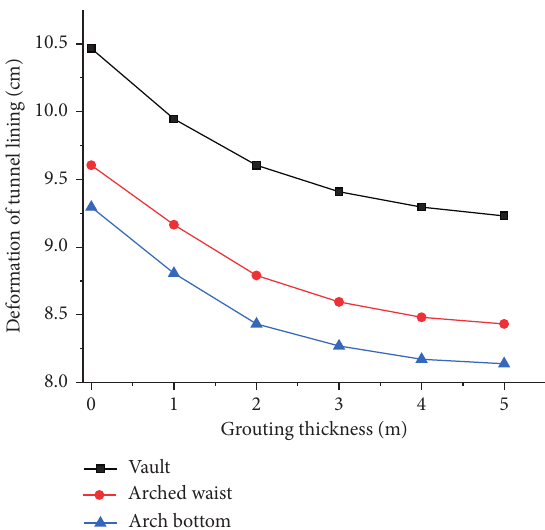
Figure 12: Lining displacement under different thicknesses of the damping